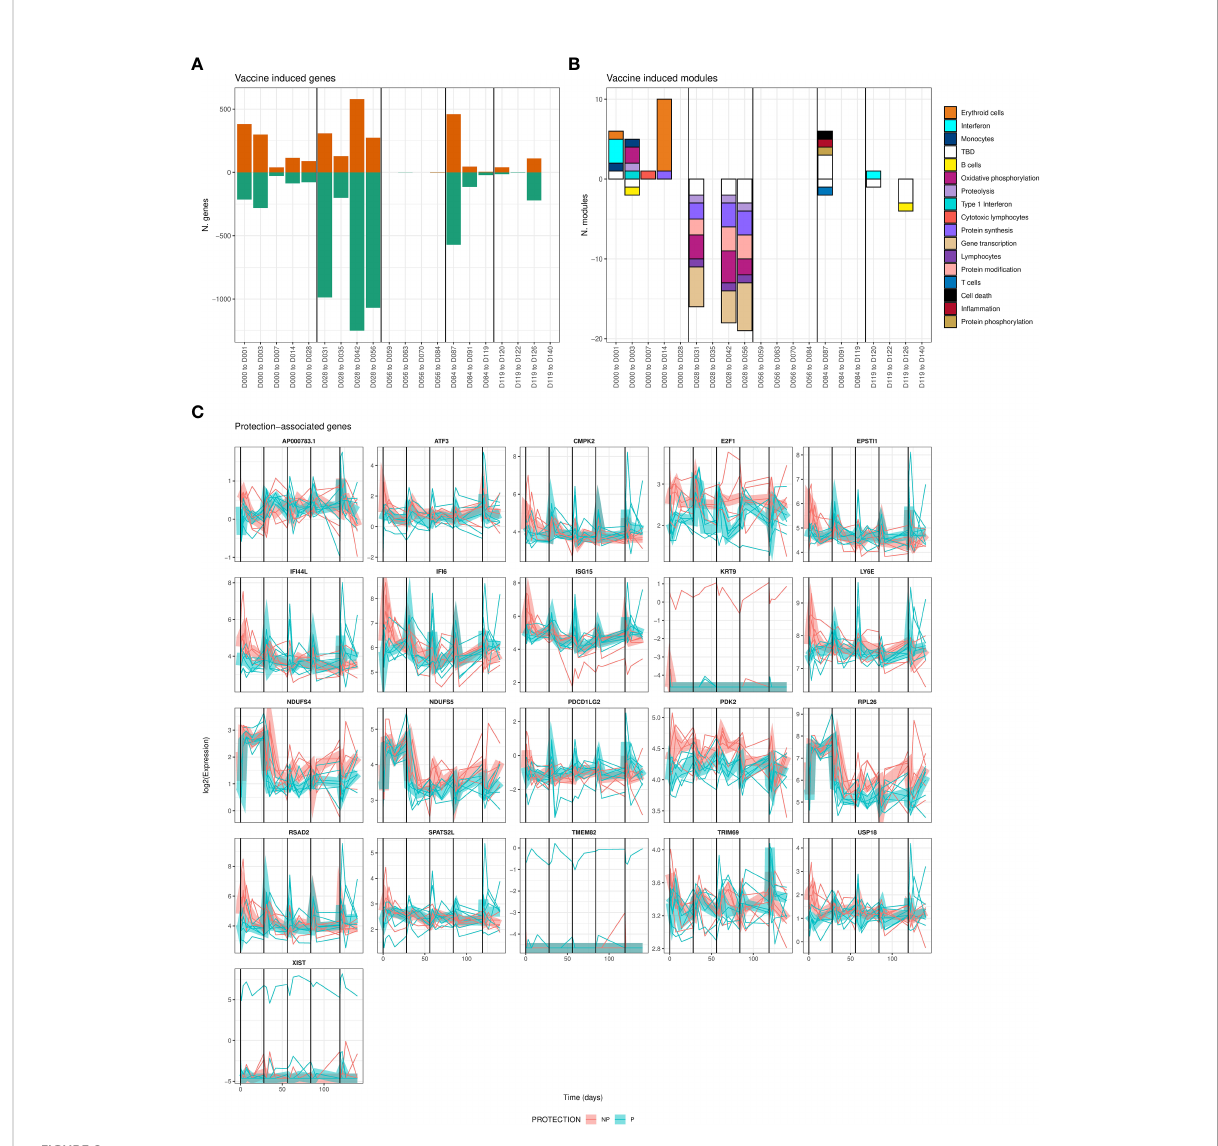
FIGURE 2 Differentially-expressed genes associated with vaccine-induced and/or protection-associated responses to immunization. (A) Bar plot showing counts of genes signi fi cantly increased (positive) or decreased (negative bar) relative to the day of the most recent vaccination. (B) Bar plot showing counts of BloodGen3 modules enriched in genes shown in A., per-timepoint and direction (positive bars represent modules enriched in genes with increased expression relative to the day of the most recent immunization, negative bars represent enrichment for genes with decreased expression). Module functional annotation is shown by the color key. (C) Line plots showing per-individual normalized expression of each signi fi cantly (FDR adjusted F-test < 0.05, comparing models including and excluding protection status) protection-associated gene over time colored by protection status. Group-averaged expression is shown as a ribbon. For all panels, vertical black lines indicate times of